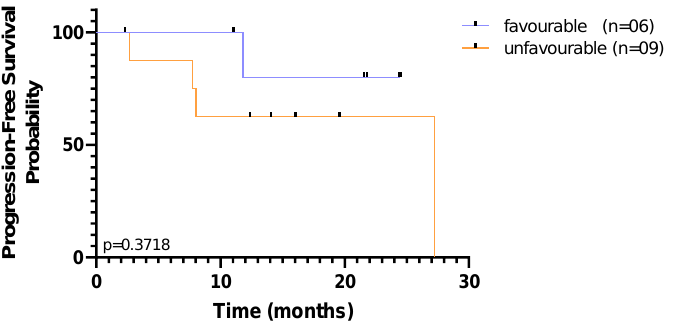
Figure 8. Kaplan–Meier curves of progression-free survival (PFS) according to favourable or unfavourable CTC count (cut-off of <5 or ≥ 5 CTCs CTCs/7.5 mL of blood in both time points—baseline and follow-up collection), using RUBYchip™ to isolate CTCs in MBC patients. Progression-free survival was calculated from the time of the baseline blood collection. Differences in survival curves were determined using the log-rank test.